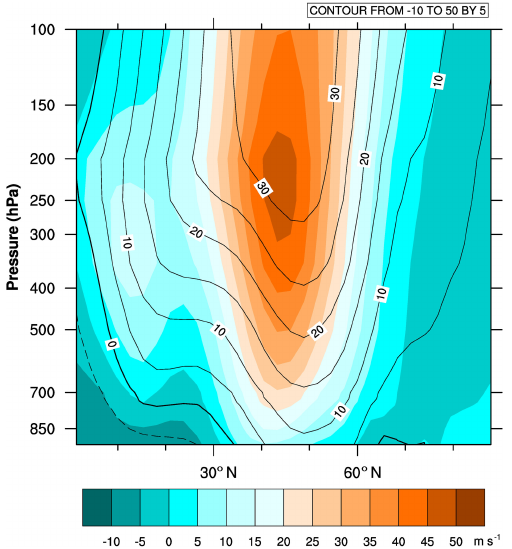
Figure 5. Ensemble average of zonal wind profiles for the NAtl for LGM in coloured contours and past1000 in contour